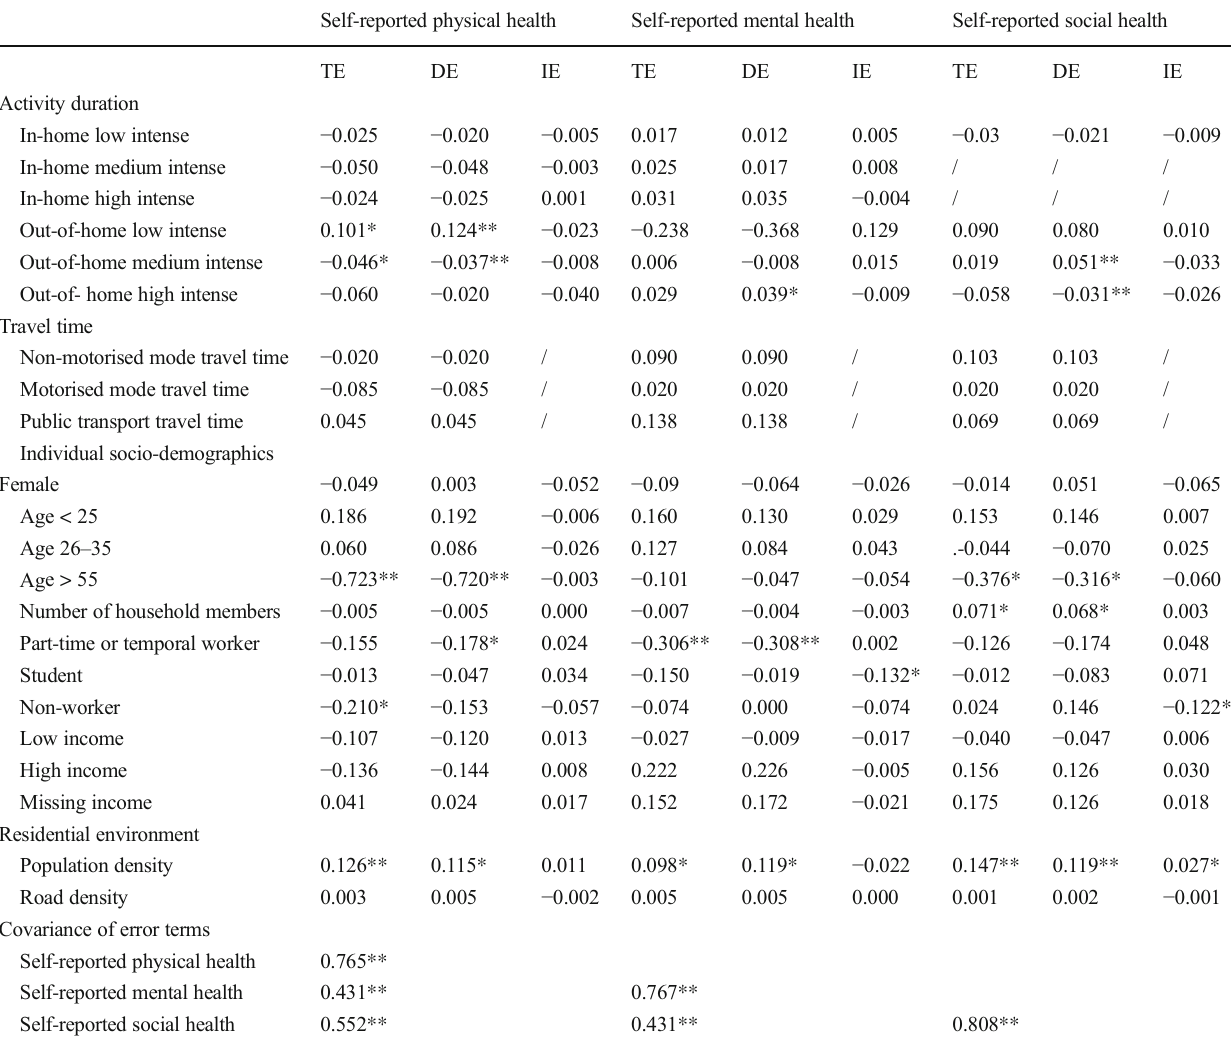
Estimation results of the effects on self-reported health factor scores Self-reported physical